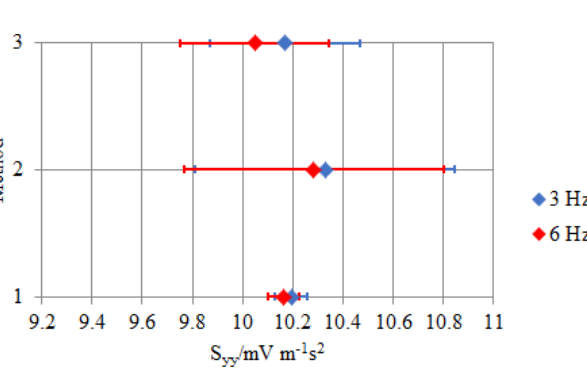
Figure 2. Test bench – scheme.